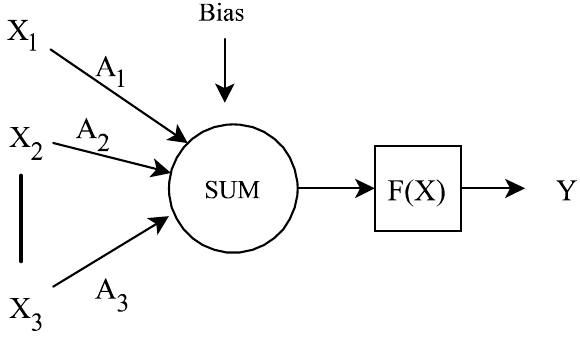
Figure 1. Neuron structure.